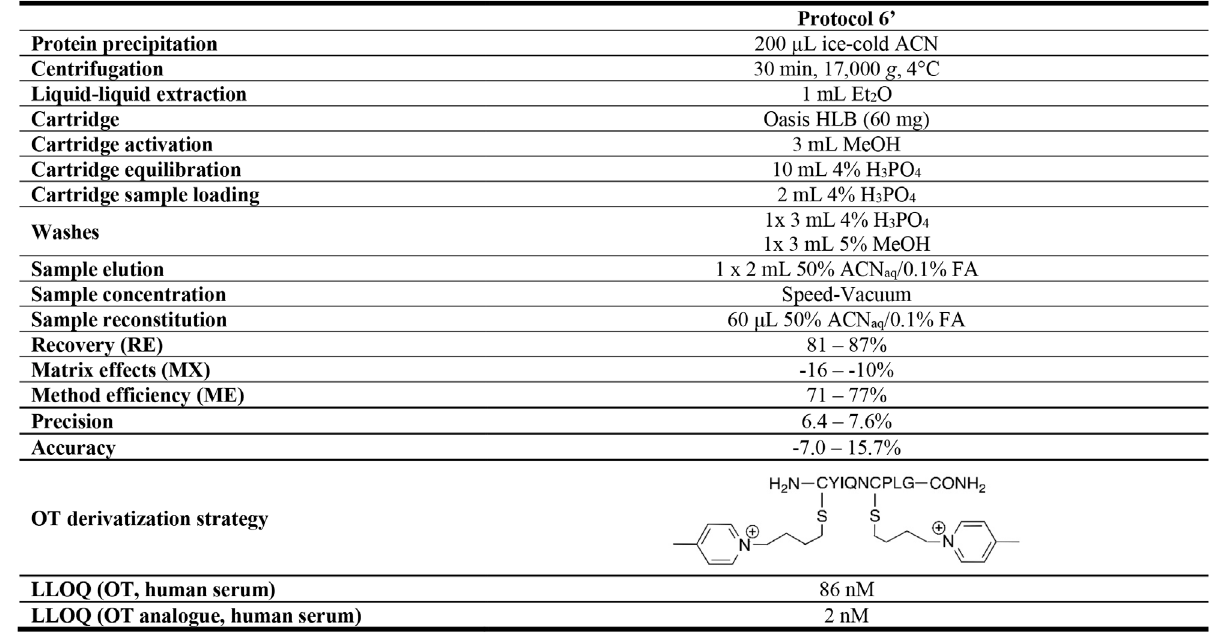
Frontiers in Chemistry |